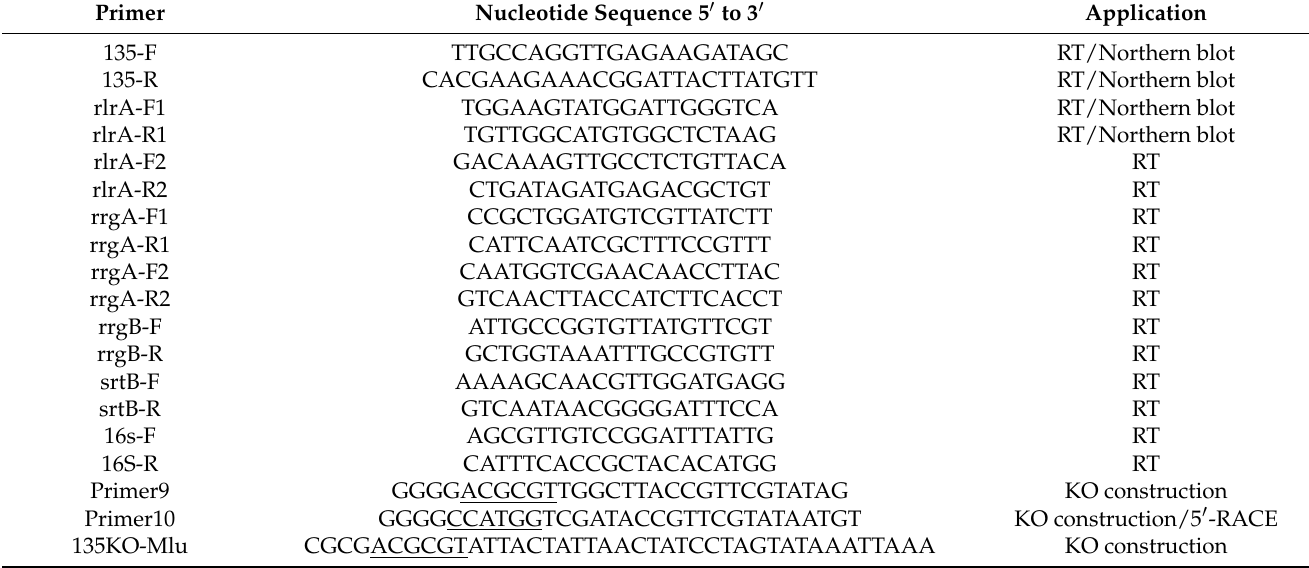
Table 2. List of primers used in this study. The underlined sequence indicates enzyme-restriction sites. RT: reverse transcription